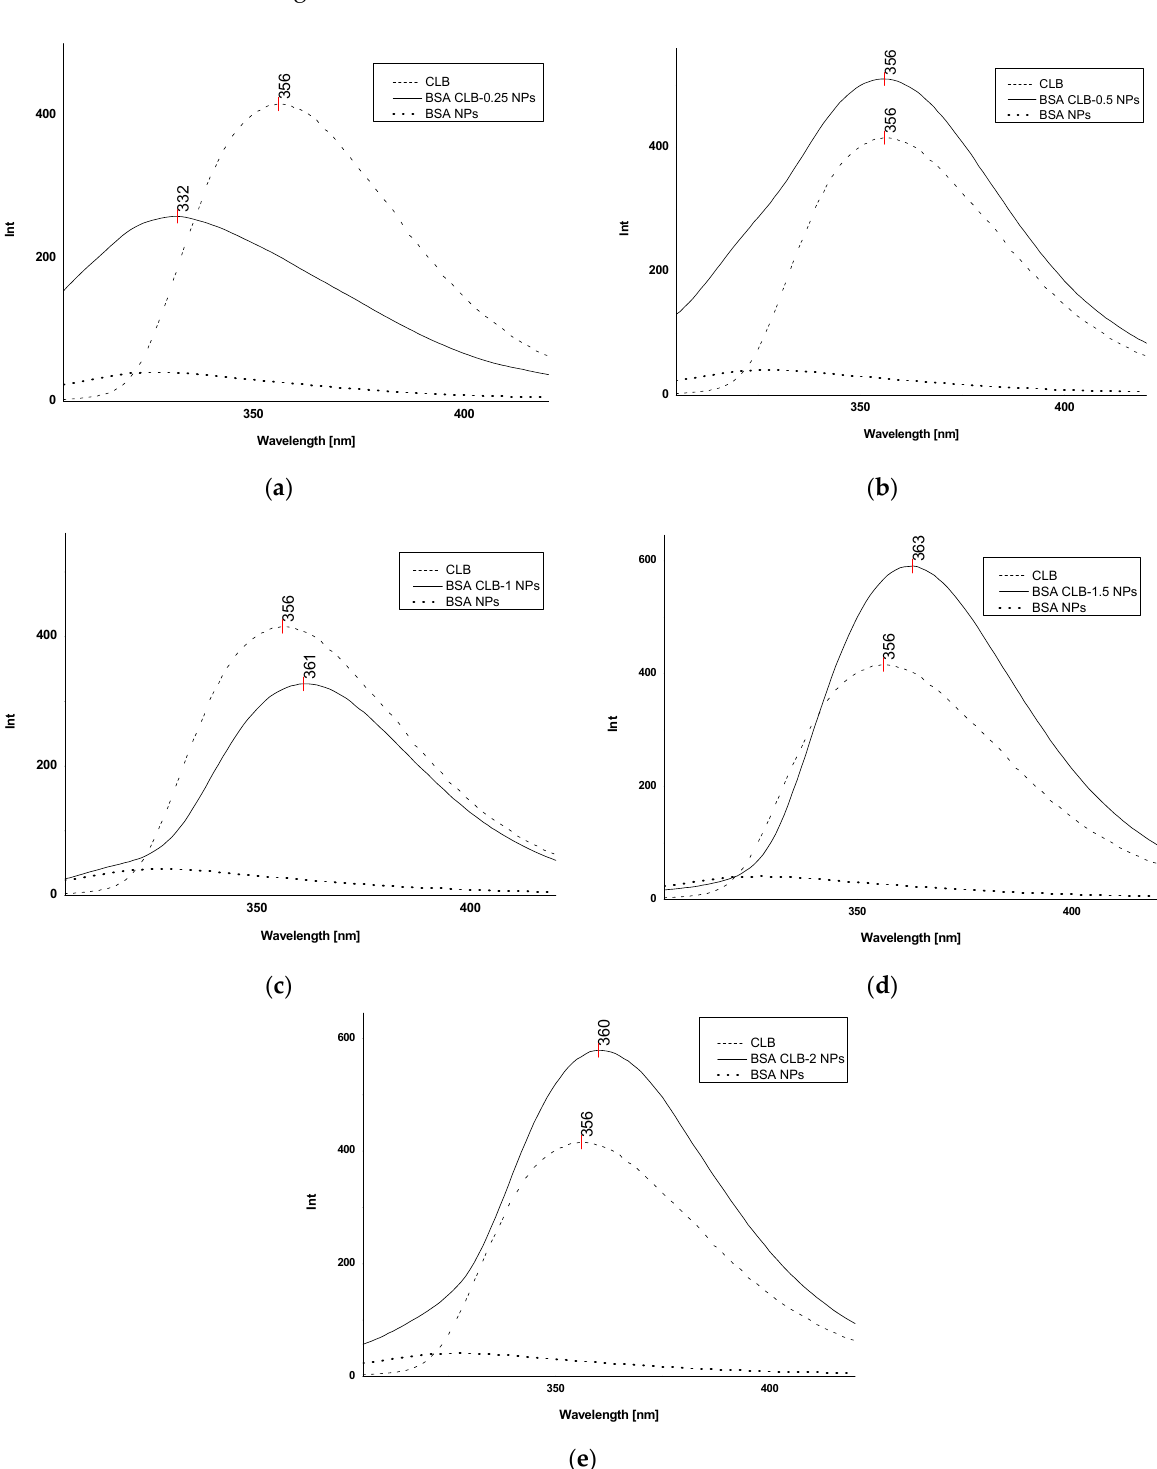
Figure 4. Fluorescence spectra ( λ ex 260 nm): ( a ) free CLB, BSA CLB ‐ 0.25 NPs and BSA NPs; ( b ) free CLB, BSA CLB ‐ 0.5 NPs and BSA NPs; ( c ) free CLB, BSA CLB ‐ 1 NPs and BSA NPs; ( d ) free CLB, BSA CLB ‐ 1.5 NPs and BSA NPs; ( e ) free CLB, BSA CLB ‐ 2 NPs and BSA NPs.